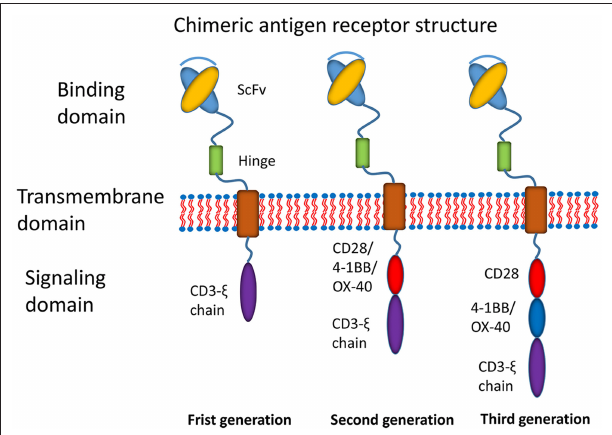
FIGURE 1 | Main structures of chimeric antigen receptors. Three generations of CAR structures. In the first generation of CARs, the binding domain (single chain antibody fragment, scFv) is linked to the signaling domain (CD3 ζ ) via the transmembrane domain. In the second generation of CARs, the costimulatory molecule (CM1, such as CD28 4-1BB or OX-40) is introduced with the signaling domain (CD3 ζ ). In the third generation of CARs, the additional costimulatory molecule (CM2) is